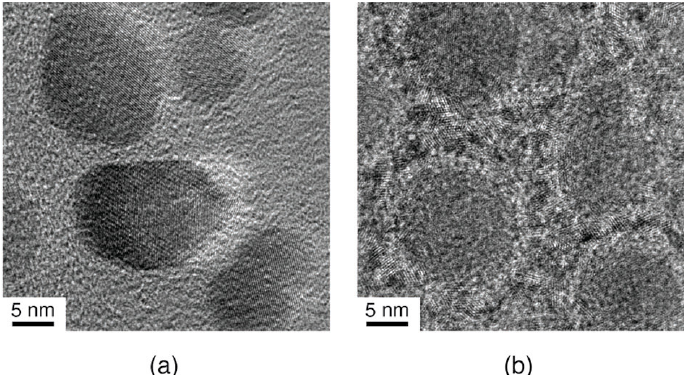
Figure 6. TEM images of EMG607 magnetic nanoparticle clusters heat-treated with the addition of Taq polymerase in PCR thermal cycles. ( a ) without Taq polymerase; (b) with 0.6 μ L of Taq